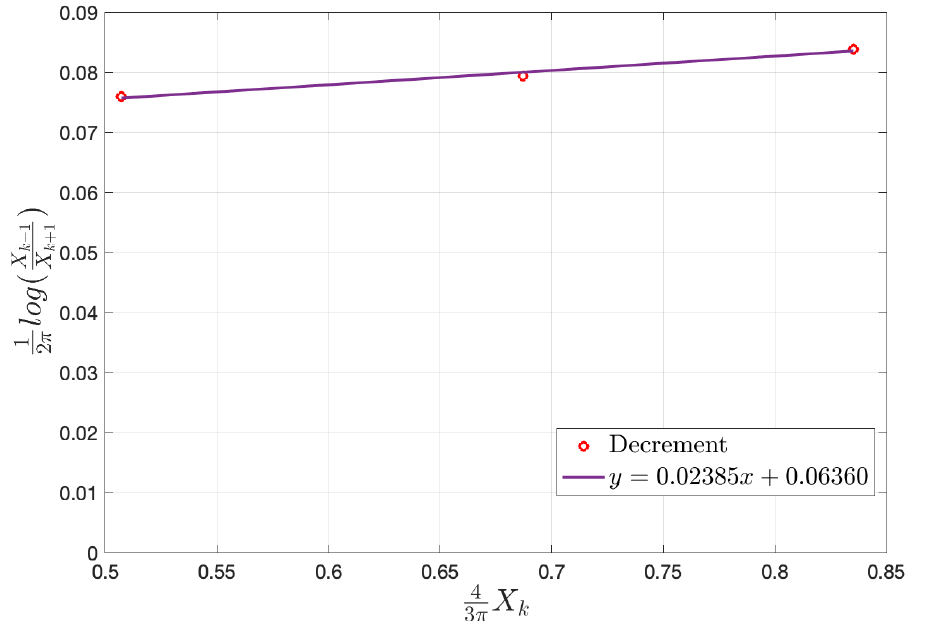
Figure 13. Extinction curve for the free decay test of heave obtained from CFD simulation with